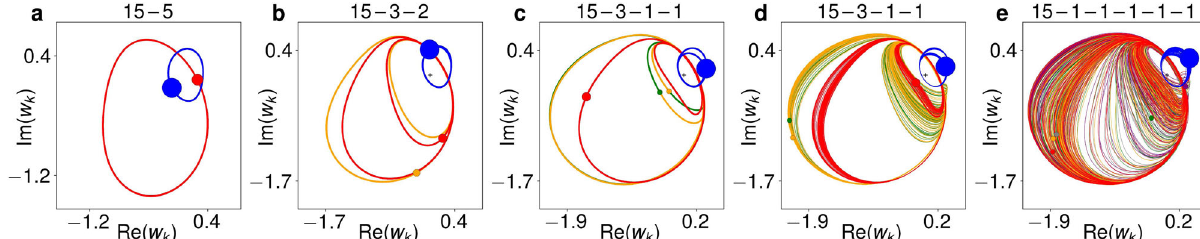
Fig. 6 Steps from 15 − 5 two-cluster solution to chimera state. Each fi lled circle refers to the instantaneous position of a cluster or single oscillator, the line of the respective same colour to its trajectory. Sizes of fi lled circles mirror sizes of clusters. N = 20, ν = 0.1 and η = 0.67, proceeding along the black line in Fig. 1k. a 15 − 5 solution for c 2 = − 0.87. b 15 − 3 − 2 period-2 solution for c 2 = − 0.82. c 15 − 3 − 1 − 1 period-4 solution for c 2 = − 0.725. The two largest loops of the two single oscillators are almost equal. d 15 − 3 − 1 − 1 three-frequency solution for c 2 = − 0.71. e 15 − (5 × 1) chimera at c 2 = − 0.705, after collision of − 33 − 19 − 12. For ε = 10 − 2 , they are 128 − 64 − 33 − 31 throughout, and for ε = 10 − 1 , 128 − 64 − 64. The same pattern to some extent already applies in the quasiperiodic domain of Fig. 3b – d, where clusters are most strongly correlated with those